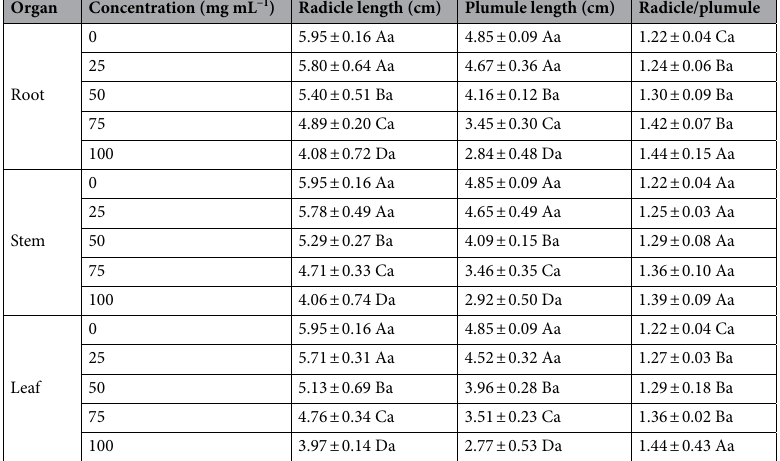
Table 2. Effects of different aqueous extracts of sesame on seedling growth. Different capital letters of the same organ in the same column indicated significant differences among different concentrations at P < 0.05 level, and different lowercase letters of the same concentrations in the same column indicated significant differences among different organs at P < 0.05 level.